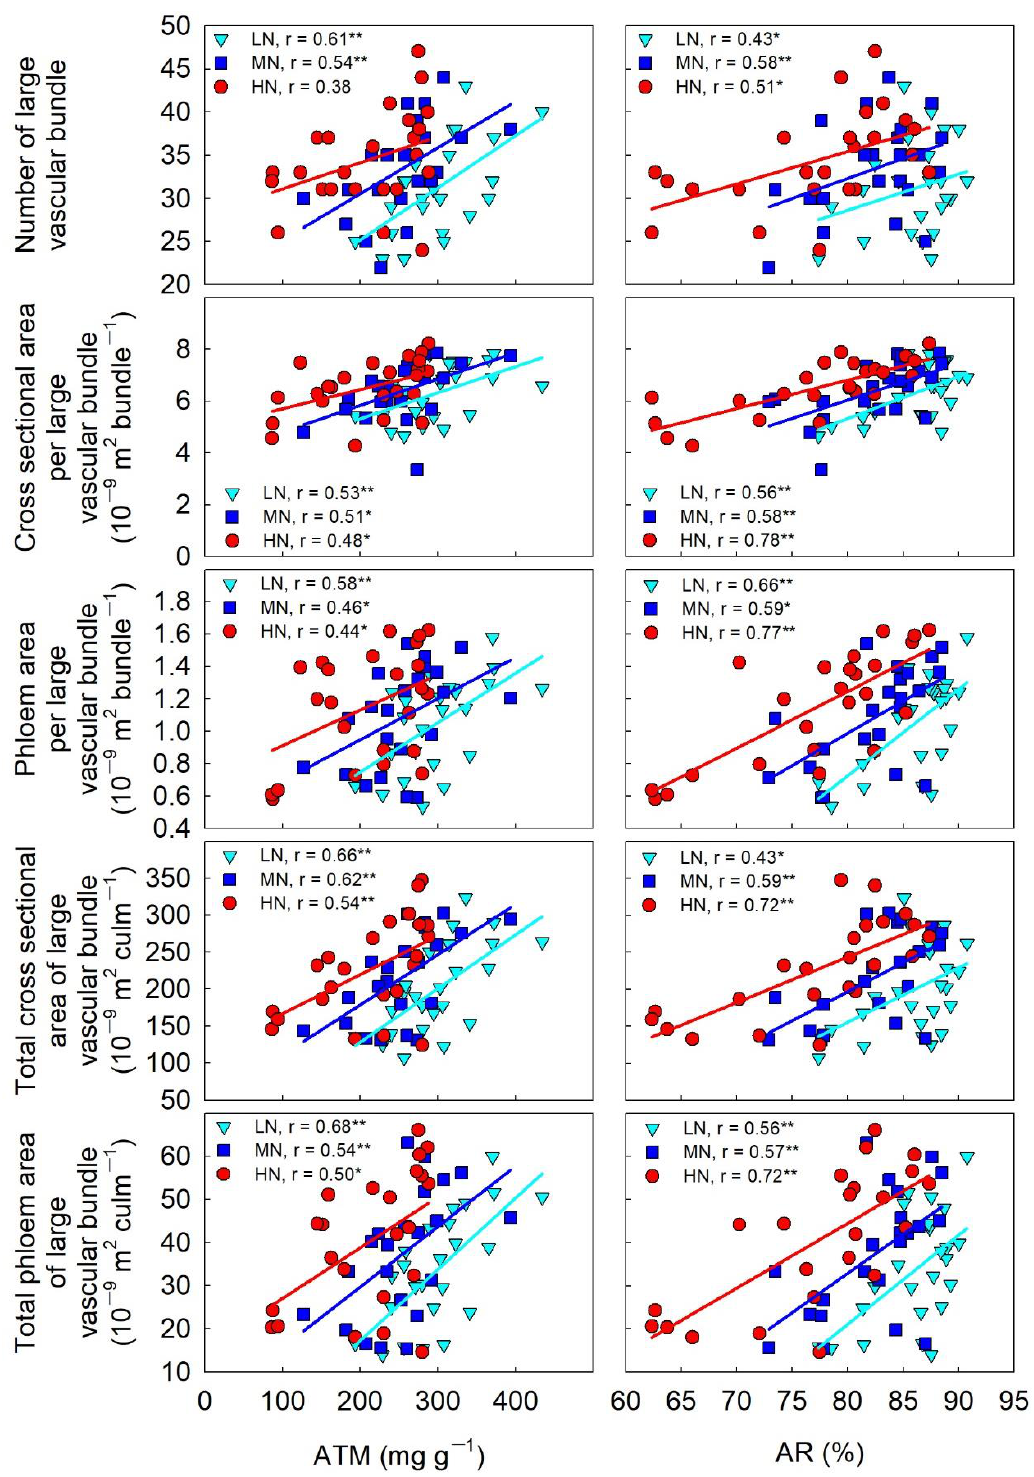
Figure 8. Correlations of LVB-related traits with stem ATM and AR. * and **, significant at p < 0.05 and at p < 0.01, respectively. LN, low nitrogen; MN, medium nitrogen; HN, high nitrogen; ATM, apparent transferred mass; AR, apparent transferred ratio.